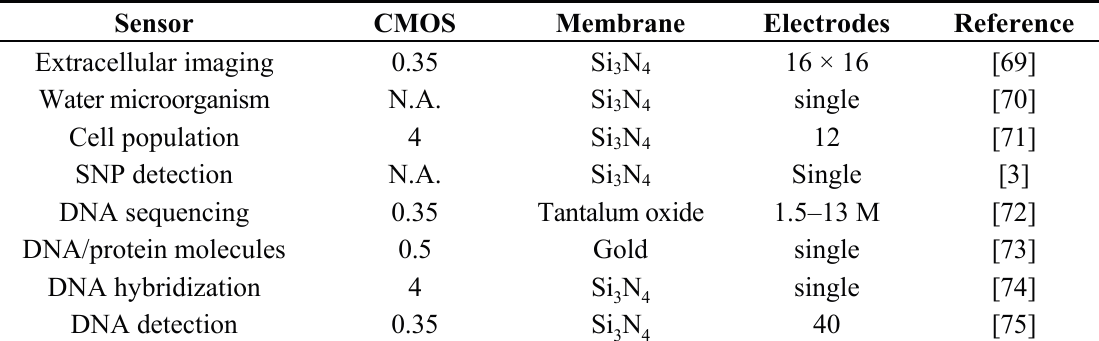
Figure 14. State of art CMOS ISFET technology: ( A ) illustration of a sample preparation and a readout system for DNA sequencing; ( B ) Simple ISFET interface circuit. Table 3. Summary of CMOS ISFET